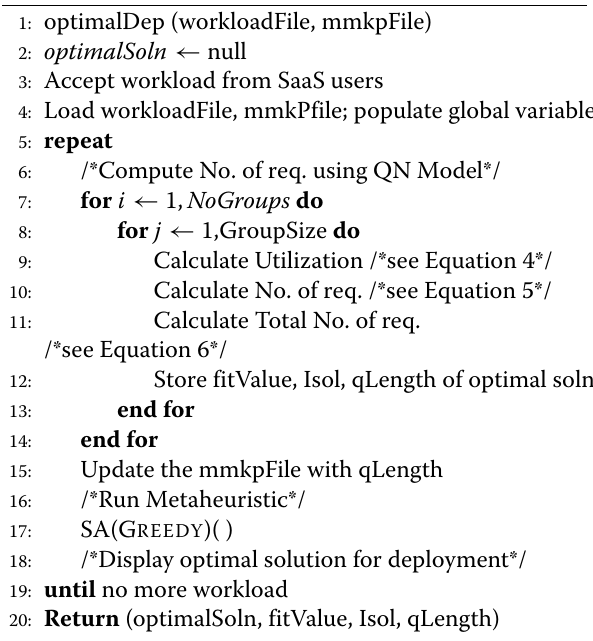
Algorithm 1 optimalDep Algorithm Algorithm 2 SA(Greedy)